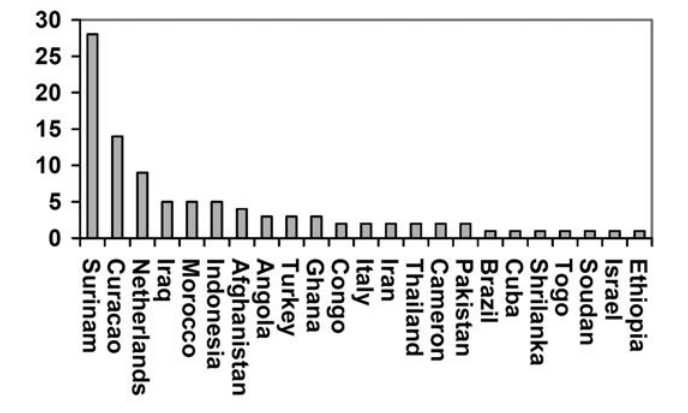
Figure 1. Ethnic distribution of the 100 individuals included in our anonymous